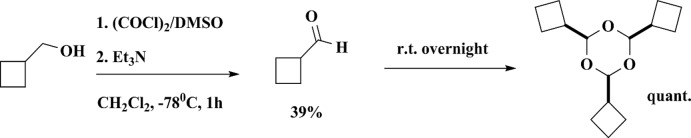
Synthesis of 2,4,6-tri­cyclo­butyl-1,3,5-trioxane, 1.